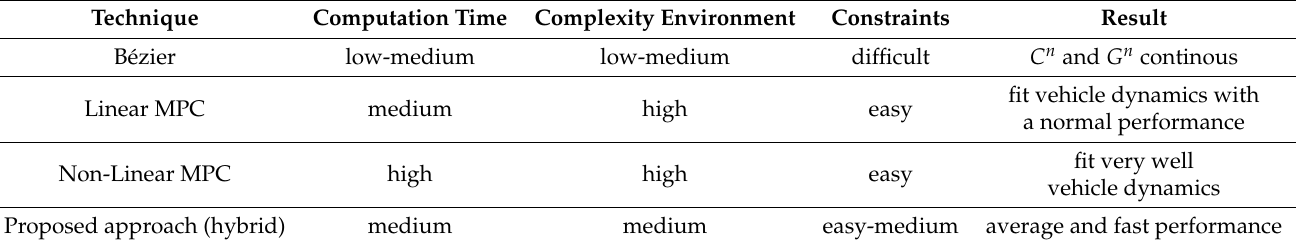
Table 2. Summary of this approach